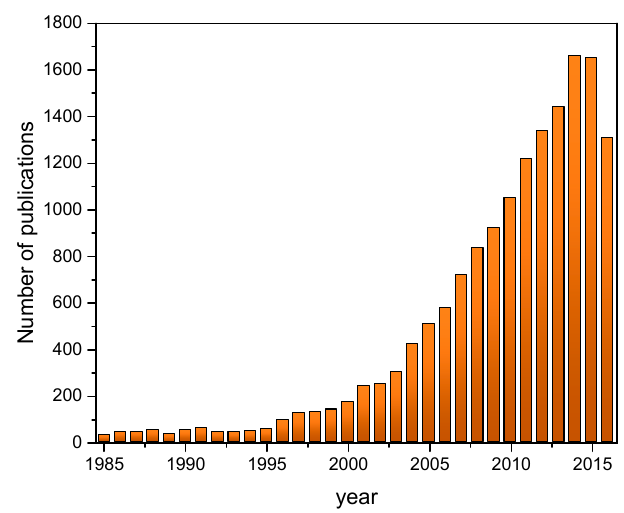
Figure 1. Number of published papers from 1985 in the Scopus Scholar database using “gold catalysts” and “CO oxidation” as search strings (September 2016).